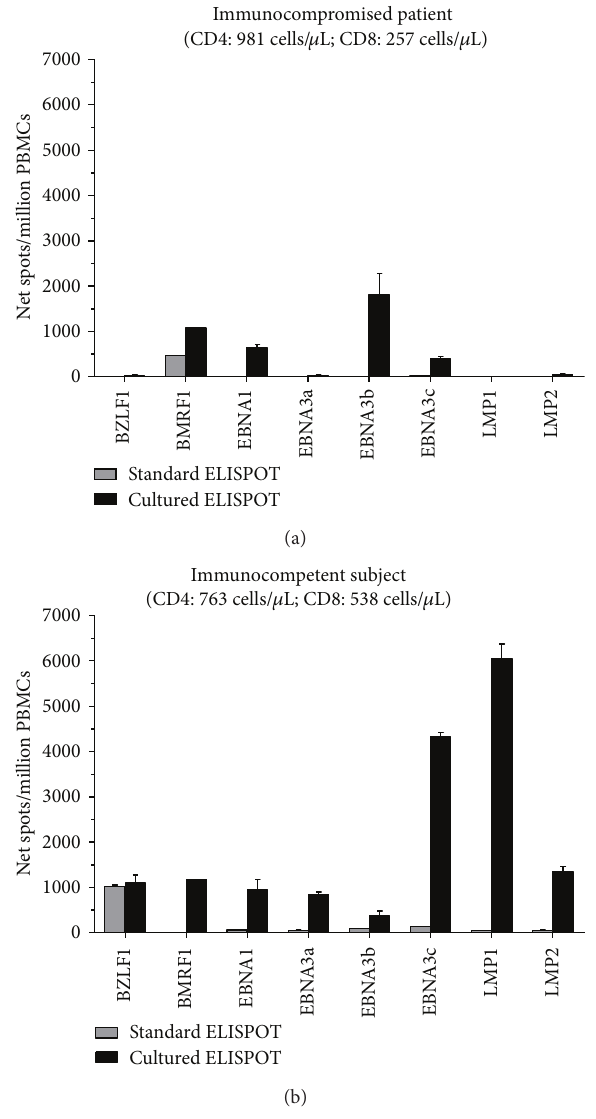
Figure 2: Epstein-Barr virus (EBV)-specific T-cell responses deter- mined by standard and cultured ELISPOT assays. Peripheral blood mononuclear cells (PBMCs) from (a) an EBV seropositive immuno- compromised patient (an hematopoietic stem cell transplant recip- ient suffering from a EBV-associated posttransplant lymphoprolif- erative disorder) and (b) an EBV seropositive healthy subject were analyzed by standard and cultured ELISPOT assays in response to peptide pools (15 amino acids in length with an 11 amino acid overlap) representing the full-length lytic (BZLF1 and BMRF1) and latent (EBNA1, EBNA3a, EBNA3b, EBNA3c, LMP1, and LMP2) EBV proteins. The mean number of spots from duplicate wells was adjusted to million PBMCs. Results are shown as net spots/million PBMCs calculated by subtracting the mean number of spots in wells with cultured medium only from the mean number of spots in wells from each EBV peptide pool. Results from the cultured ELISPOT wereadjustedperproliferationindex(numberofantigen-stimulated cells after 10 days of culture divided by the number of medium- stimulated cells after 10 days of culture). Error bars represent the standard error of the mean. T-cell subsets indicated are at the time of ELISPOT